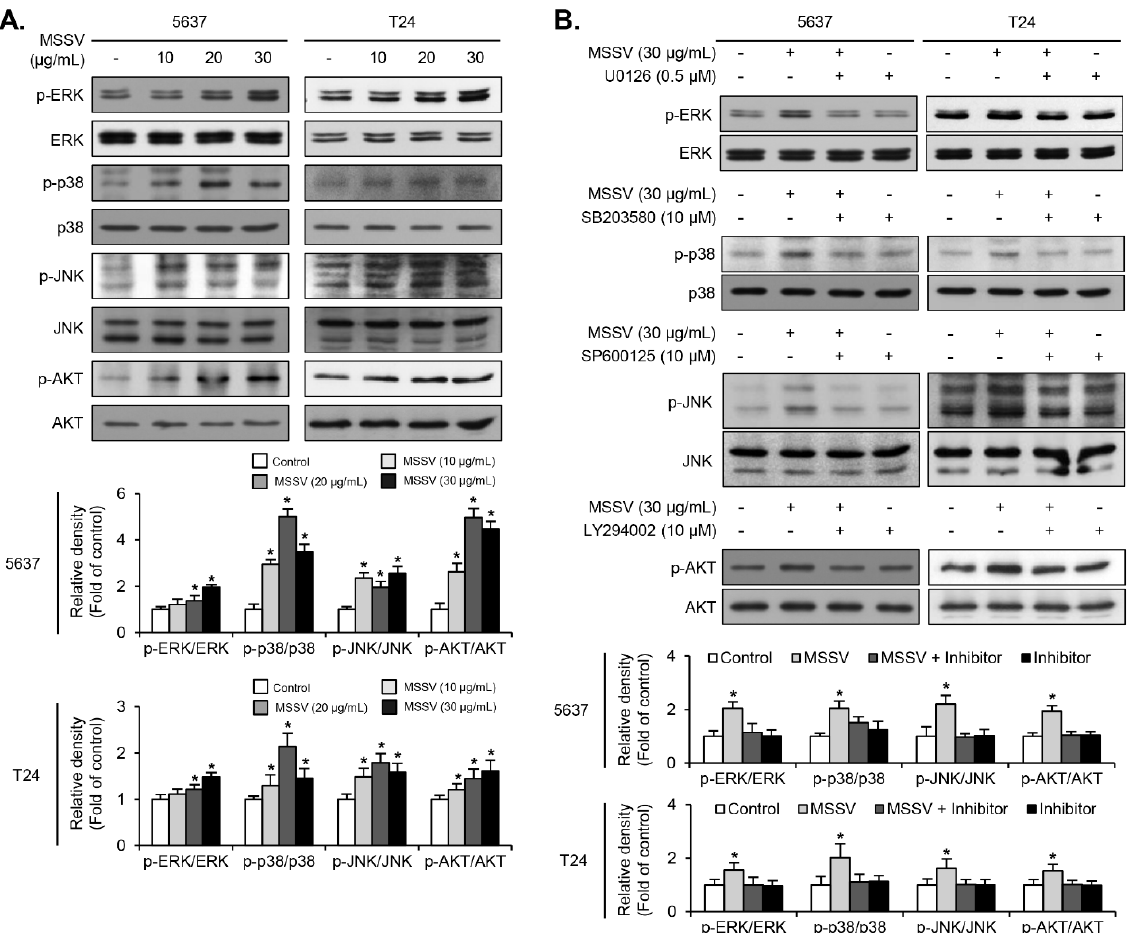
Figure 3. Signaling pathways mediating the anti-proliferative effect of MSSV in bladder cancer cells. ( A ) Both cells were treated with MSSV at the indicated concentrations for 24 h. The cell lysates were subjected to immunoblot analysis with phosphorylated and total forms of MAPKs (ERK1/2, JNK1/2, and p38) and AKT; Results were expressed as fold changes in comparison with the control cell lysates. ( B ) Both cells were pretreated with biochemical inhibitors of U0126 (0.5 µ M), SB203580 (10 µ M), SP600125 (10 µ M), and LY 294002 (10 µ M) for 40 min. MSSV was then added for another 24 h, followed by immunoblot analysis. The ratio of phosphorylated to non-phosphorylated form was measured and expressed as fold changes in comparison with the ratio associated with MSSV treatment. For the bar graphs, values are presented as the mean ± SD of three independent experiments; * p < 0.05, compared with the control group. Uncropped Western Blot Images in Figures S5 and